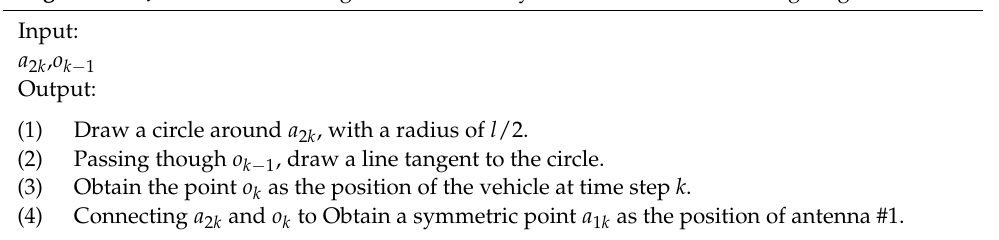
Algorithm 3 Joint rectification algorithm while only one antenna detects enough